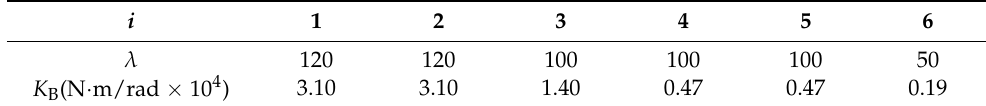
Table 3. The parameters of the harmonic reducers.